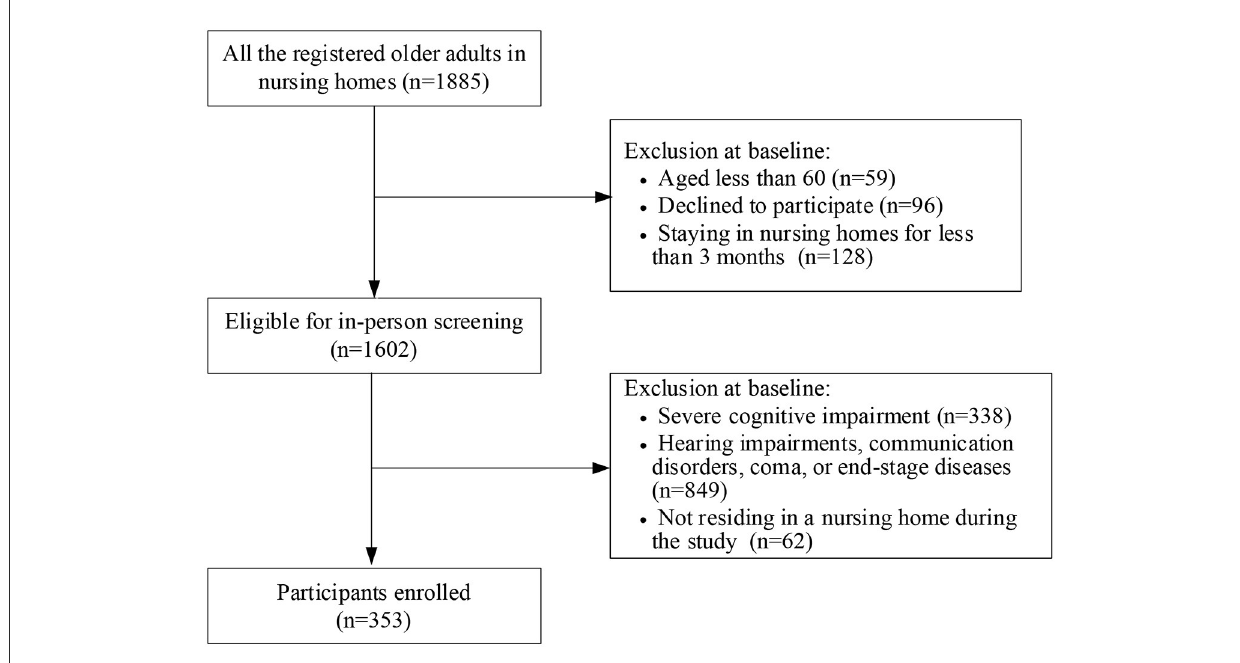
FIGURE1 Flowchart depicting participant selection